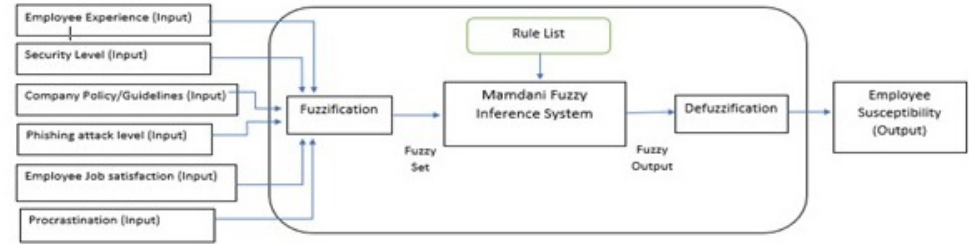
Figure 4. Susceptibility system design.